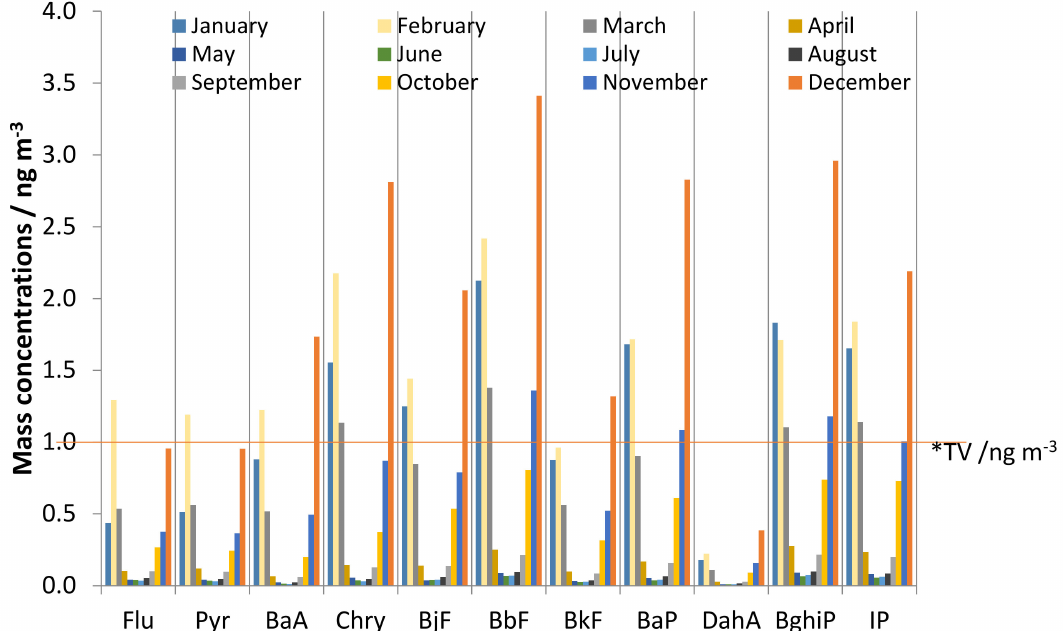
Figure 3. Monthly mass concentrations of PAHs measured during one calendar year. * The target value (TV) in the European Union set by Directive 2004 / 107 / EC for BaP content in PM 10 fraction is 1 ng m − 3 averaged over a calendar